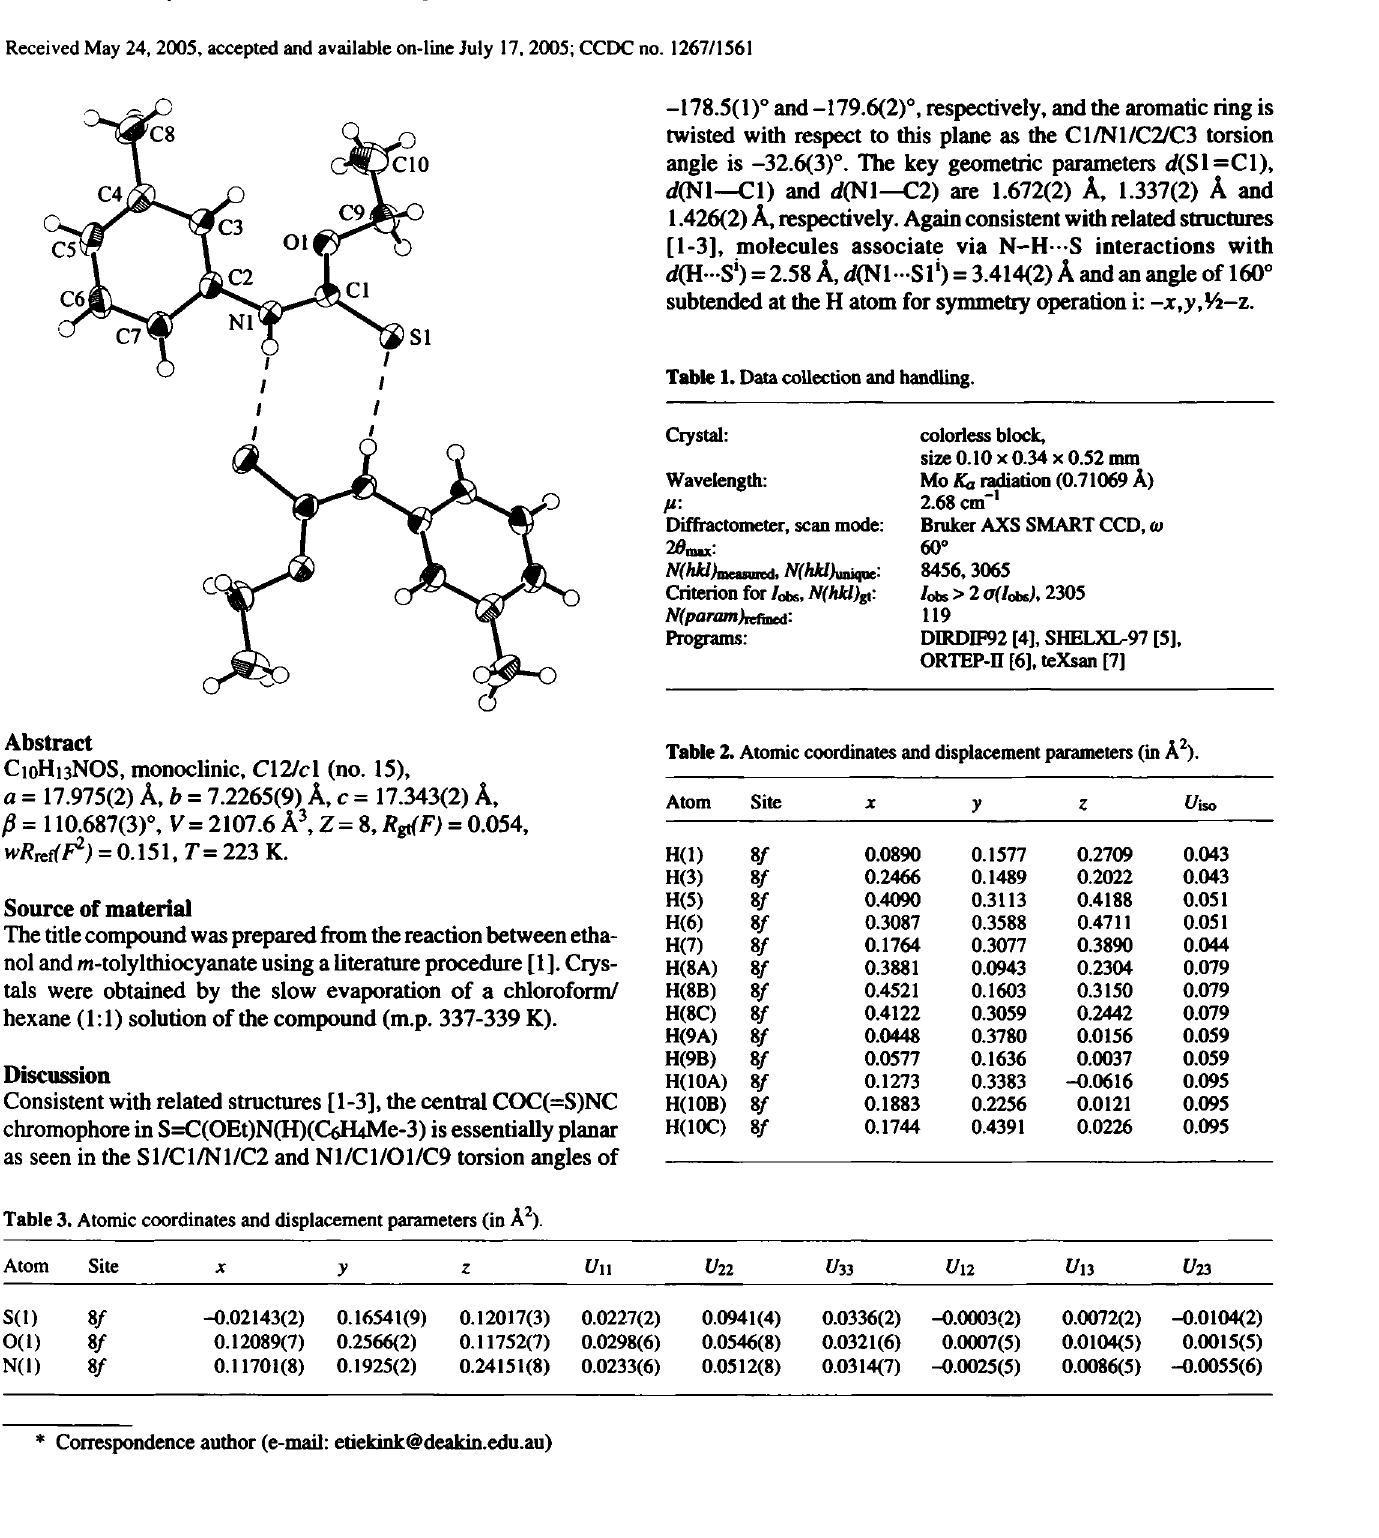
Table 3. Atomic coordinates and displacement parameters (in A 2 ).